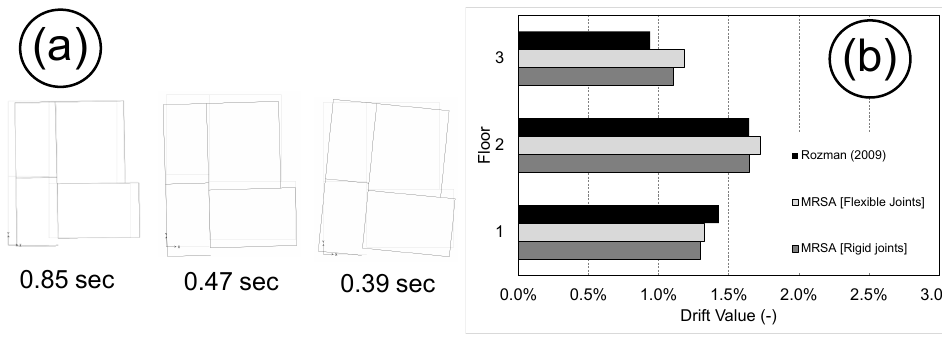
Figure 12. Validation of MRSA applied to the SPEAR frame: ( a ) Modal analysis results [Note. The first three relevant modes amount 86% and 82% of participating masses in X and Y directions, respectively]; ( b ) MRSA drifts results.